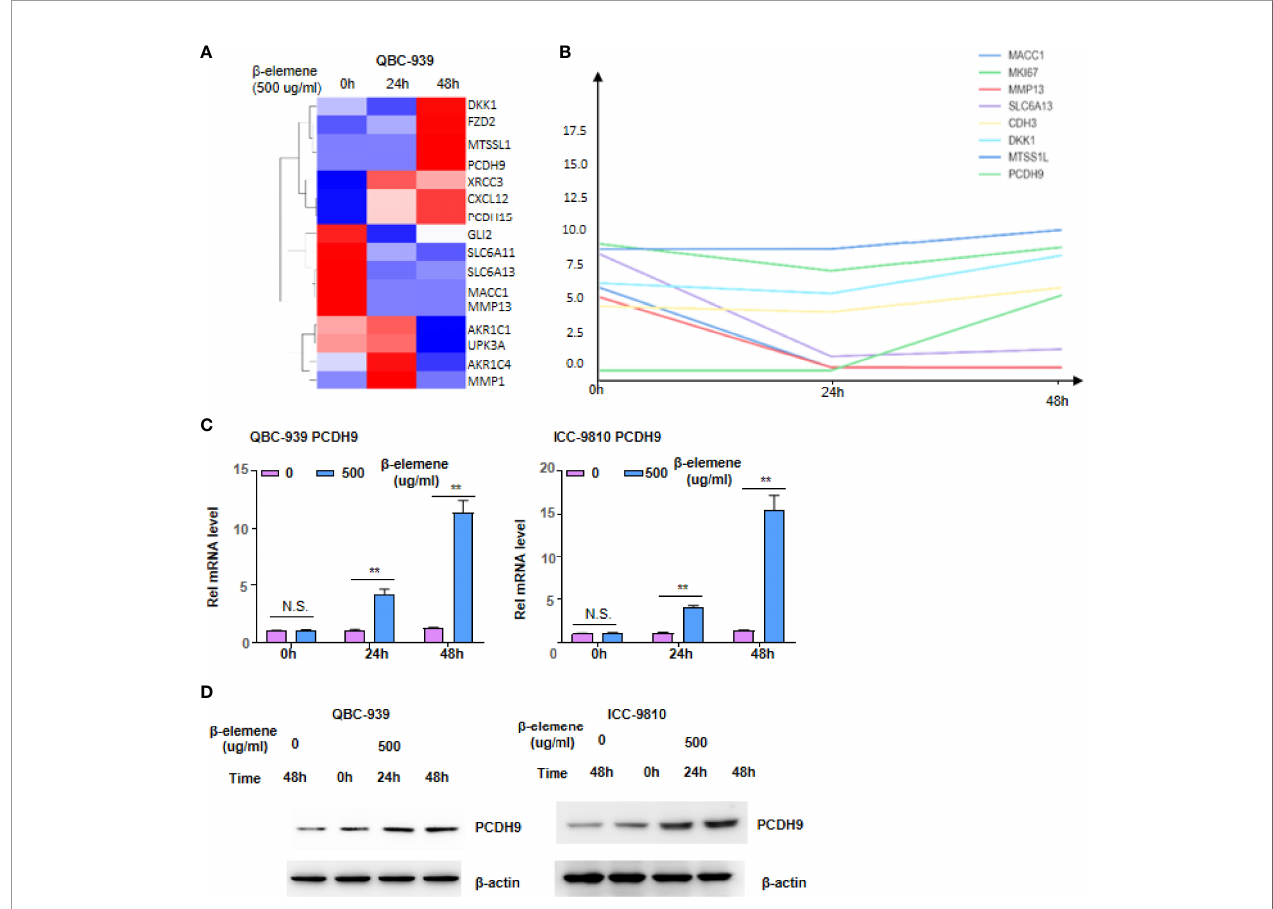
FIGURE 3 | b -Elemene induces aberrant expression of invasion/metastasis-related genes, especially PCDH9 . (A, B) Cluster of changed genes involved in tumor invasion and metastasis (A) and the linear trend of selected genes at indicated time points (B) . (C, D) qRT-PCR (C) and Western blotting (D) analyzed PCDH9 in QBC-939 and ICC-9810 cells following b -elemene treatment at indicated concentrations and time points. NS, not signi fi cant; ** p <